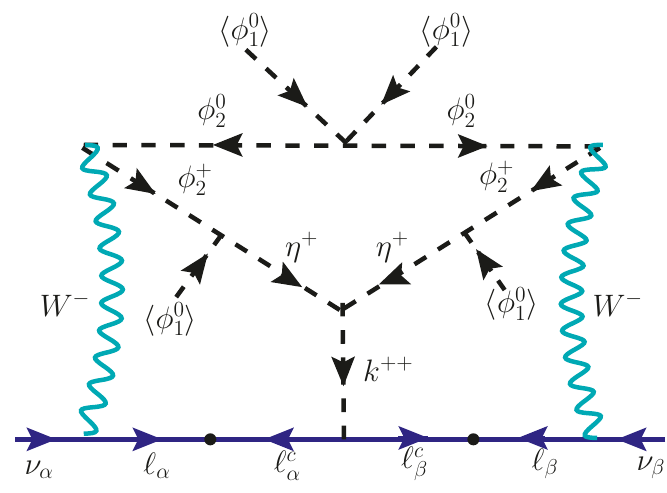
Figure 54 . Three-loop neutrino mass generation in the cocktail model [39]. The e(cid:11)ective operator induced is of eq. O d =15